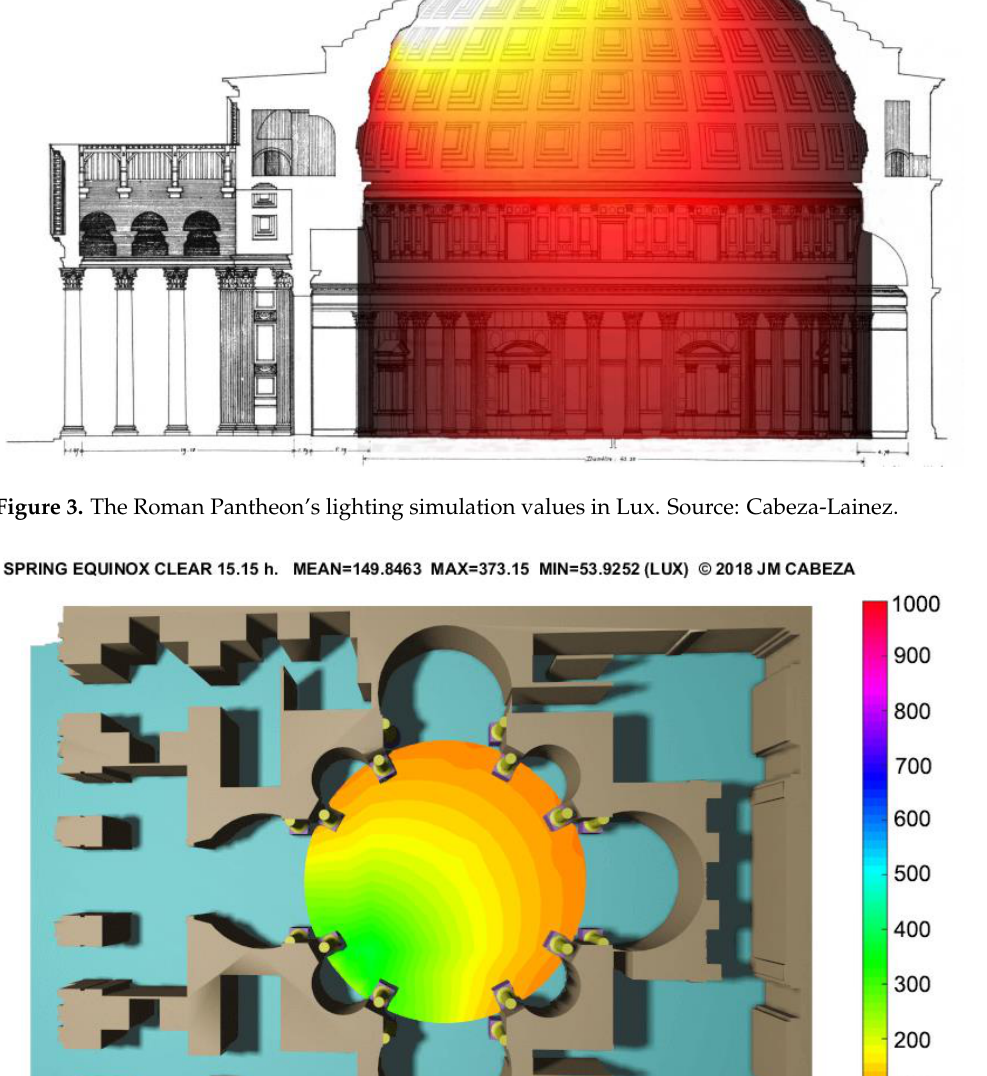
Figure 3. The Roman Pantheon ’s lighting simulation values in Lux. Source: Cabeza-Lainez.